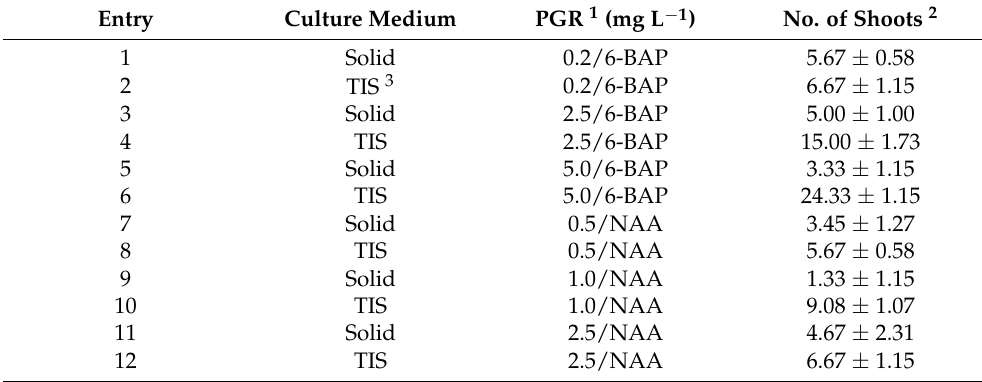
Table 1. Culture system and plant growth regulator effects on shoot number in R. officinalis